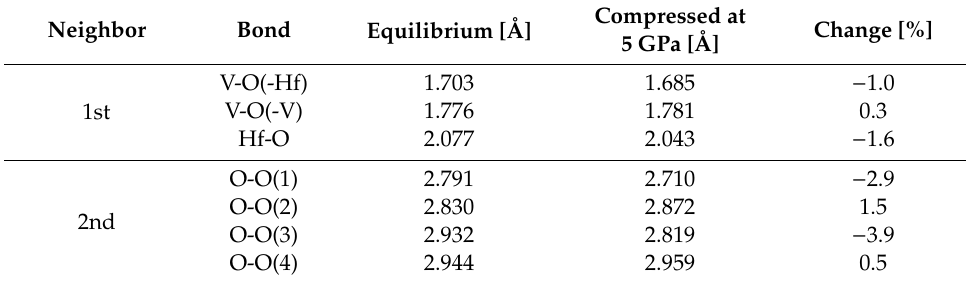
Table 1. Comparison of individual bond lengths in equilibrium and upon uniform compression (5 GPa), that is, hydrostatic pressure with uniform uniaxial strains, for the full relaxation at every volume (FR) approach.